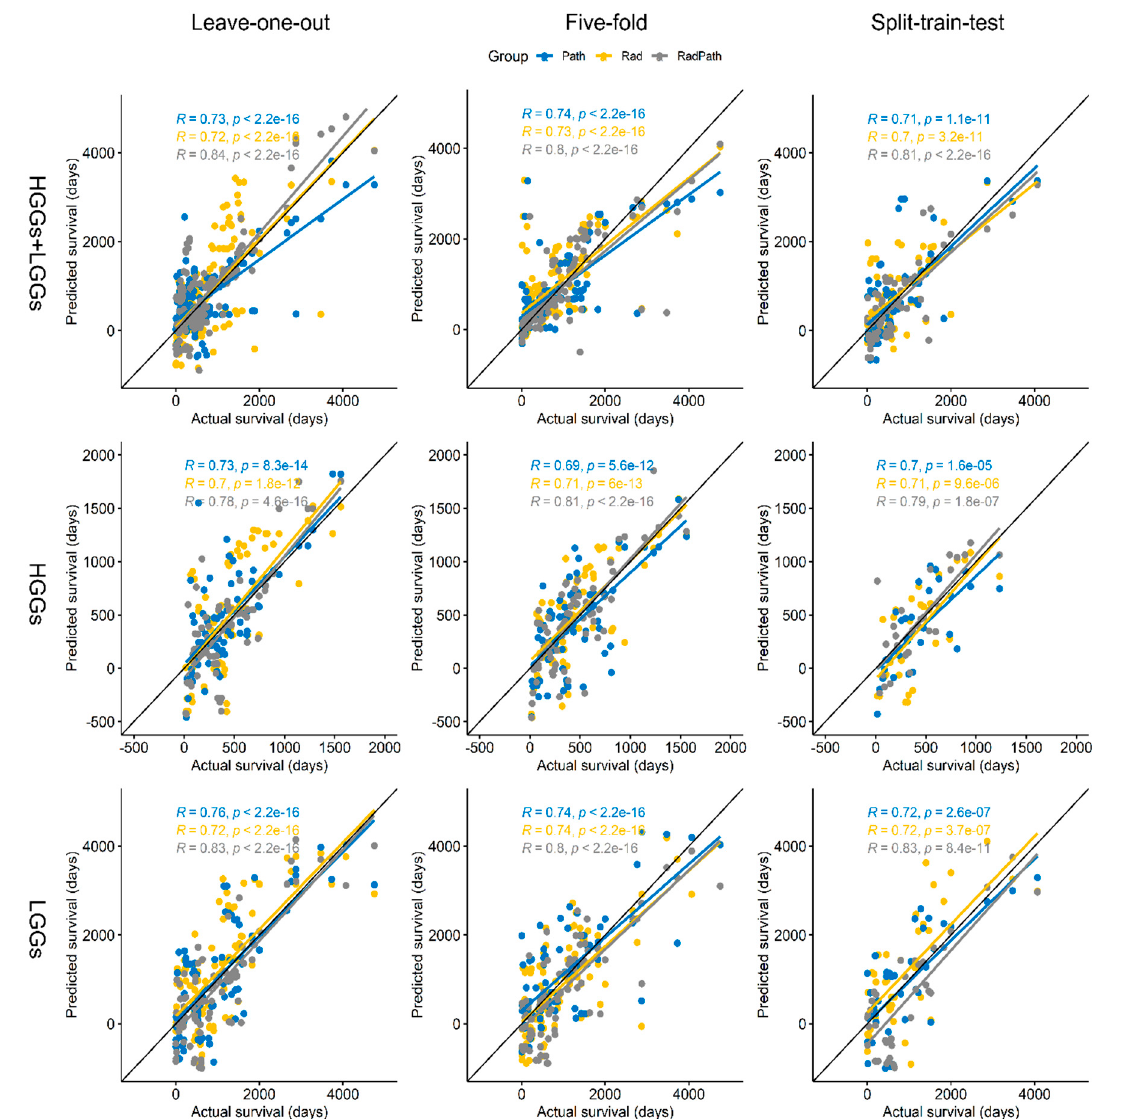
Figure 2. Survival predictions based on different validation methods. Left to right columns: LOO (configuration-I), 5 fold CV (configuration-II), split-train-test (configuration-III). Top to bottom rows: HGGs + LGGs, HGGs, and LGGs.